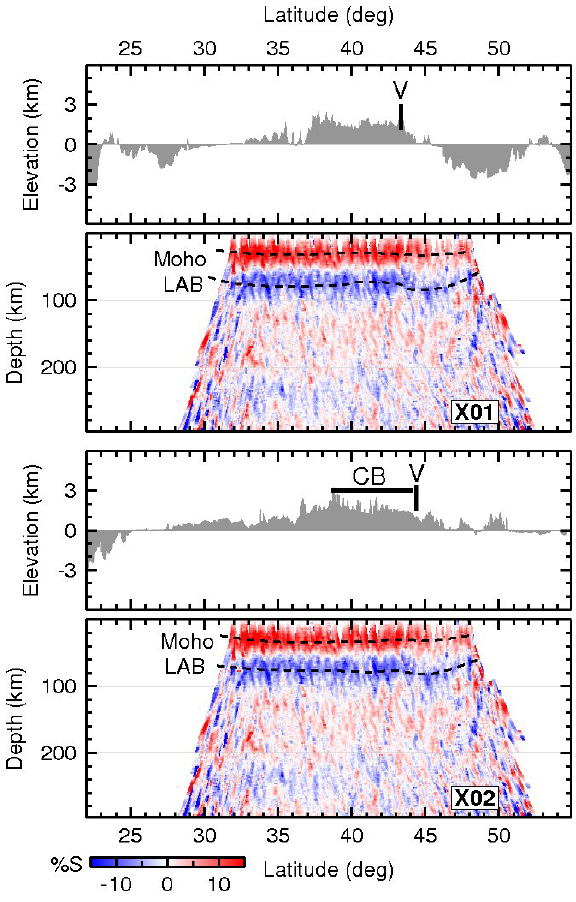
Fig. 13. Migrated S receiver functions along profiles X01 and X02 as in Fig. Migrated S receiver functions along profiles X01 and X02 as in Fig. 3.